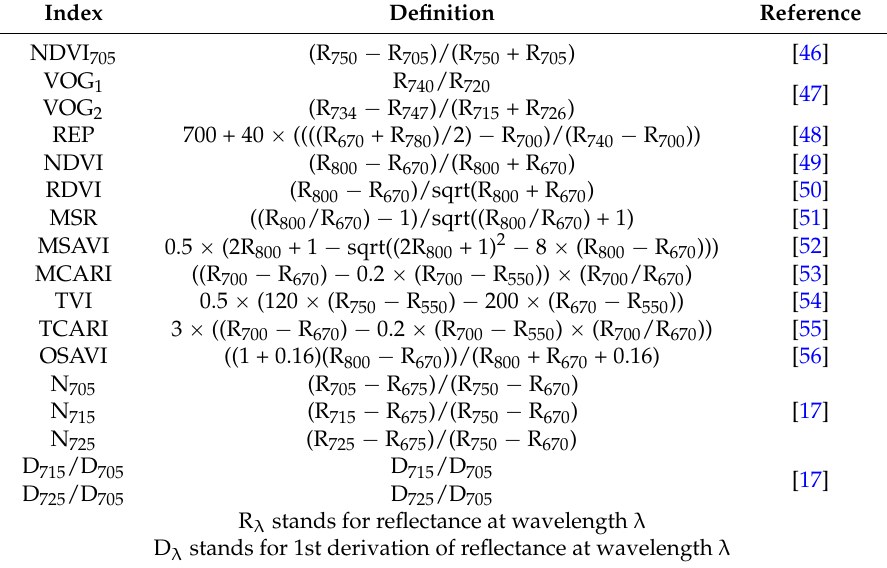
Table 3. List of vegetation indices used in this